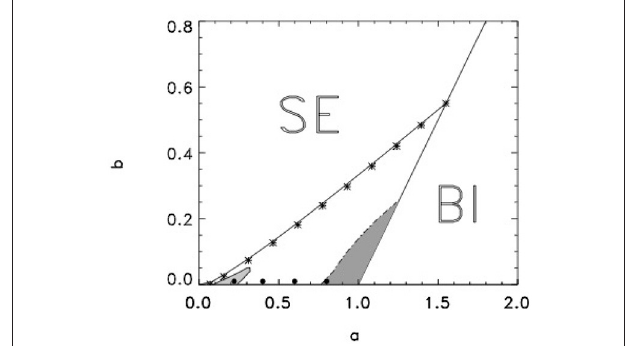
FIGURE 3 | Parameter space of the modified Barkley model with k ǫ = 4 and ǫ = 0.005. Within the light gray domain tip trajectories look like epi- or hypo-trohoids, like in Figure 1 . Within the dark gray domain the tip trajectories are more complicated and disordered. Within the white domain spiral waves rotates around a circular core. Black spots correspond to parameter values used in Figure 4 .